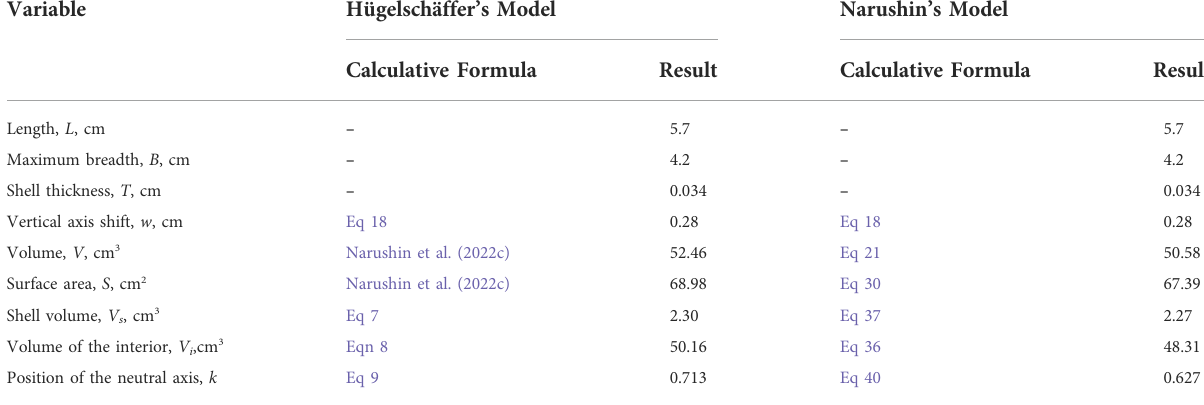
TABLE 1 Results of comparative analysis of egg parameters using Narushin ’ s and Hügelschäffer ’ s